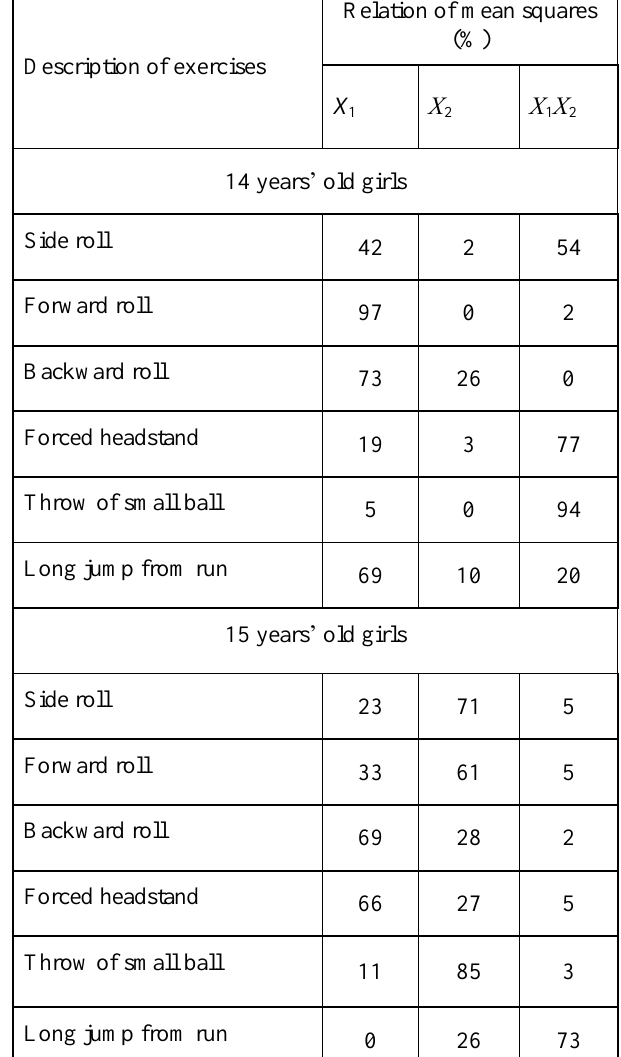
on training of physical exercises by pupils of 14-15 years’ old age Relation of mean squares Description of exercises